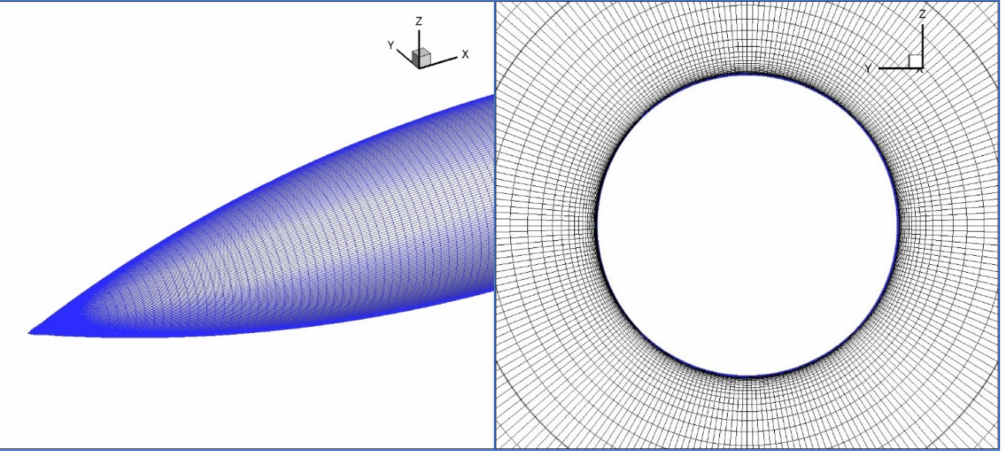
Figure 2. Detail of the structured grid (Grid S1). ( Left ) surface mesh on the nose tip. ( Right ) transversal plane